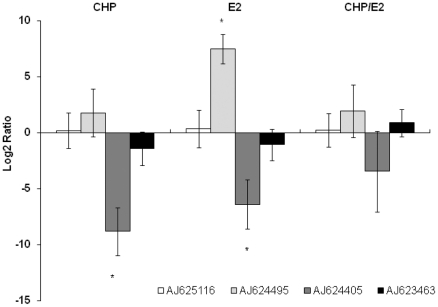
RT-Q-PCR analysis.Actin (AJ625116); GM2-activator protein: GM2-AP (AJ624495), GM2-AP
(AJ624405); hexosaminidase (AJ623463). The actin gene analyzed by
RT-Q-PCR, which showed no expression changes from microarray analysis,
was included in this survey as a confirmation of the normalization
process based on the expression of the 18S rRNA. Log2 group mean
relative expression levels with respect to control (DMSO/ETOH)
±SD (n = 4) are reported; *
 = p<0.05 Mann-Whitney U test.